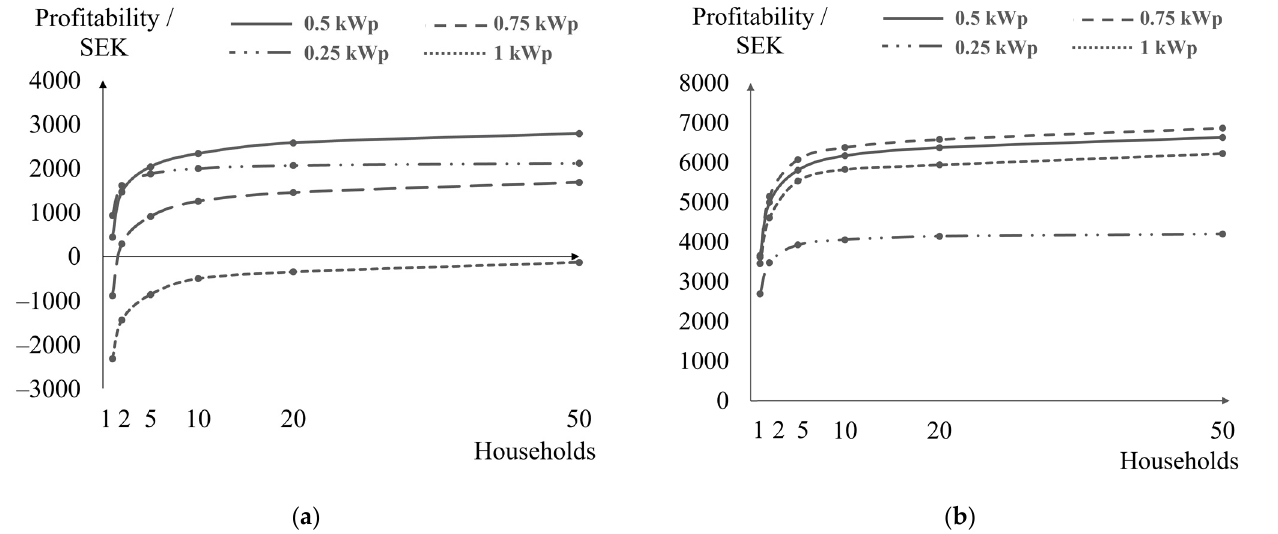
12 of 17 Figure 8. Average household profitability with a 0.25 kWp PV system in Karlstad. Comparison be- tween electricity price growth scenarios of 2% and 3%. Further, Figure 9a,b shows the average household profitability for different PV sys- tems (0.25 kWp, 0.5 kWp, 0.75 kWp, and 1 kWp) in the same combination sizes. Figure 9a shows the results for an electricity price growth of 2%, wherein the 0.25 kWp and 0.5 kWp